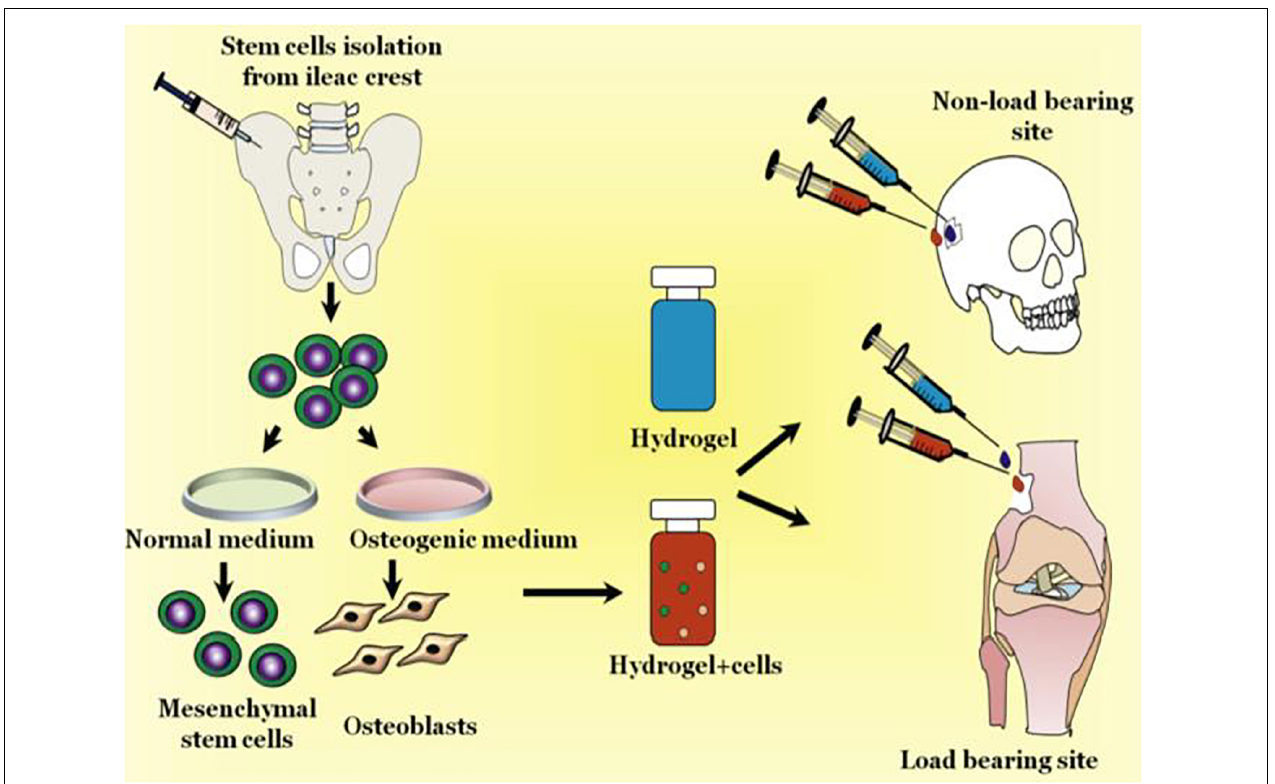
FIGURE 2 | Schematic representation of injectable hydrogels for treating bone loss at defective sites. Reproduced from Saravanan et al. (2019) with permission from Copyright 2019